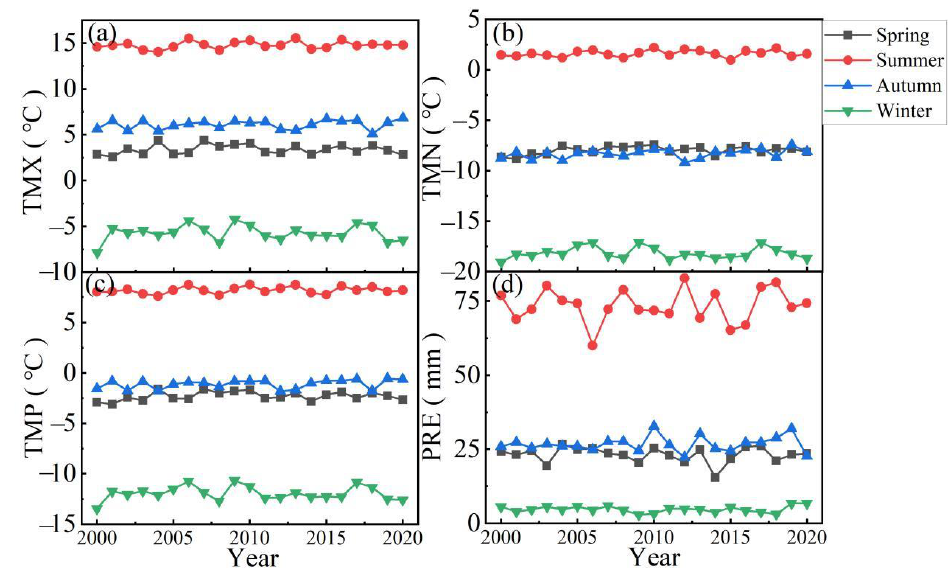
Figure 5. Seasonal climate changes in the TP from 2000 to 2020, ( a ) TMX, ( b ) TMN, ( c ) TMP, ( d ) PRE, respectively.